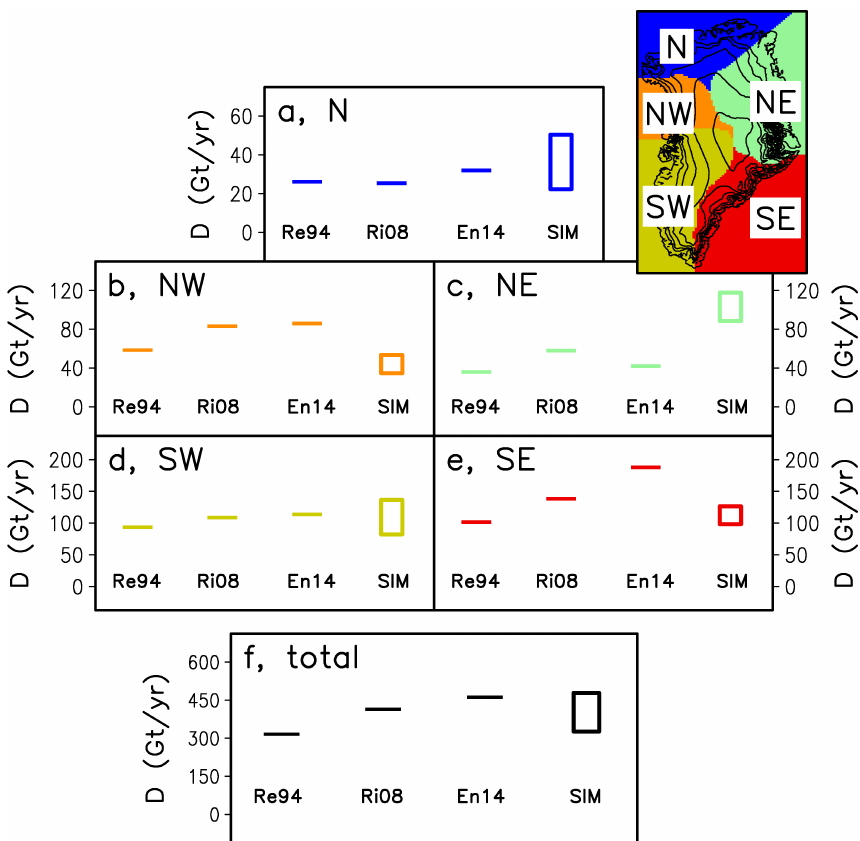
Figure 10. Simulated ice discharge (open bars) versus observations and findings by others (horizontal lines) at present day (i.e. pre-industrial conditions). The heights of the open rectangles indicate the range of our simulated discharge. Acronyms are as follows: Re94: Reeh (1994), Ri08: Rignot et al. (2008) and En14: Enderlin et al. (2014). Further on, SIM indicates our simulations. (a) – (e) Sectoral Greenland ice discharge in Gtyr − 1 for the northern (N), north-western (NW), north-eastern (NE), south-western (SW), and south-eastern (SE) parts (colours of the sectors are indicated in the inset). (f) Total ice discharge in Gtyr − 1 . Note that the y axes have different